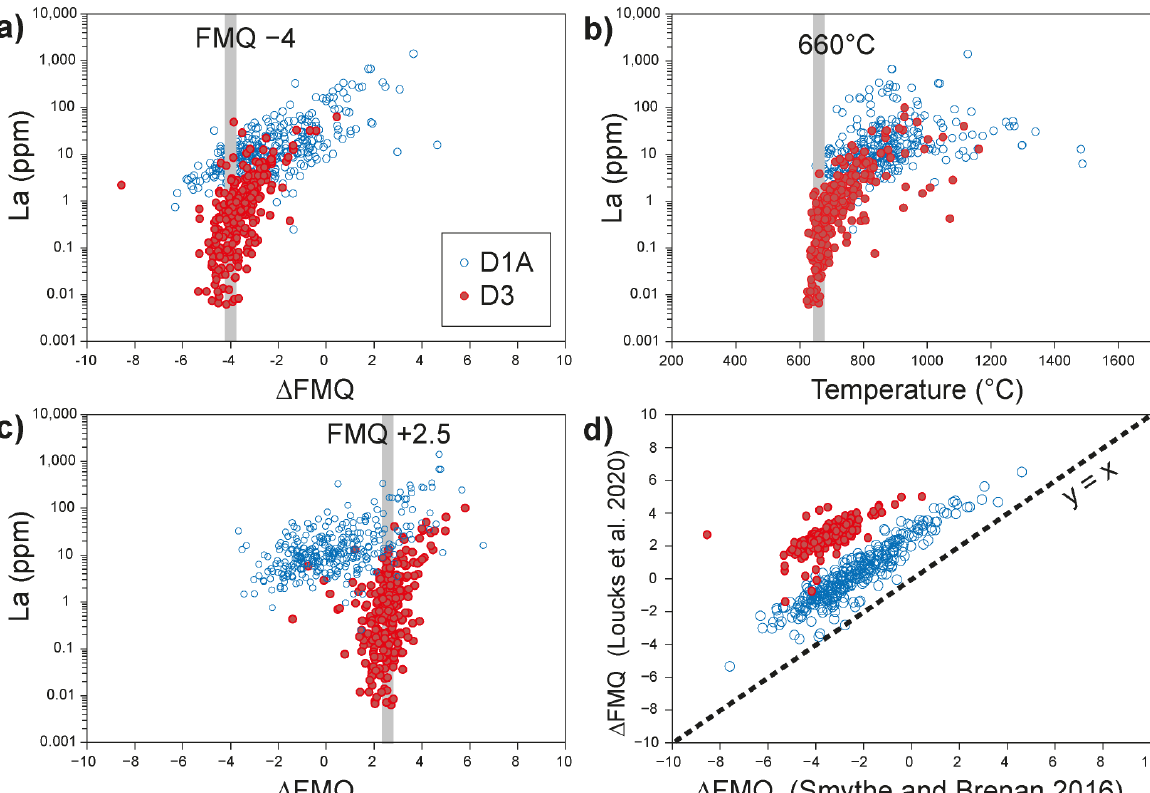
Figure 10. Binary diagrams displaying the ( a , c ) La vs. oxidation state, with the oxidation state expressed in terms of deviation from the fayalite-magnetite-quartz (FMQ) buffer, and the ( b ) La vs. temperature parameters. These parameters are calculated for zircon and using the methods of Smythe and Brenan [53] ( a , b ) and Loucks et al. [54] ( c ), and results from these two methods were compared using a binary diagram ( d ).